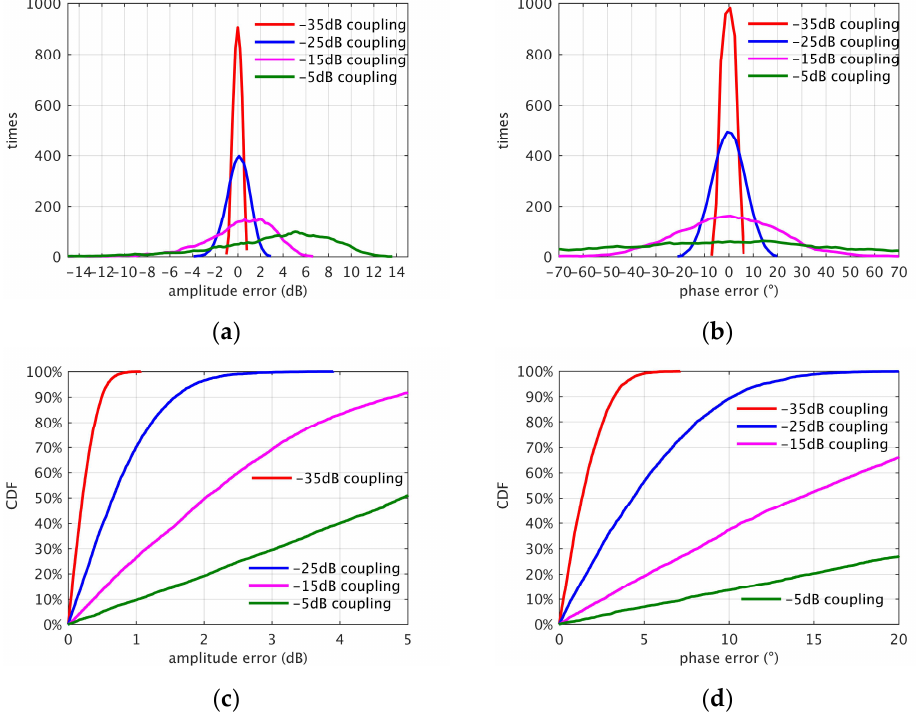
Figure 7. ( a ) Statistical distribution of amplitude error under different coupling magnitudes; ( b ) statistical distribution of phase error; ( c ) cumulative distribution of amplitude error; ( d ) cumulative distribution of phase error.